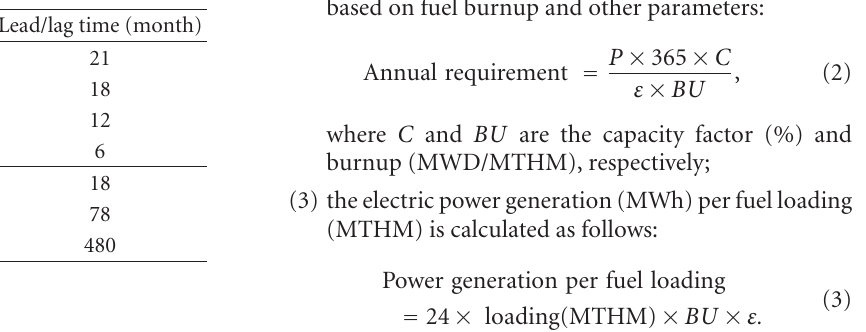
Table 2: Lead and lag time of fuel cycle